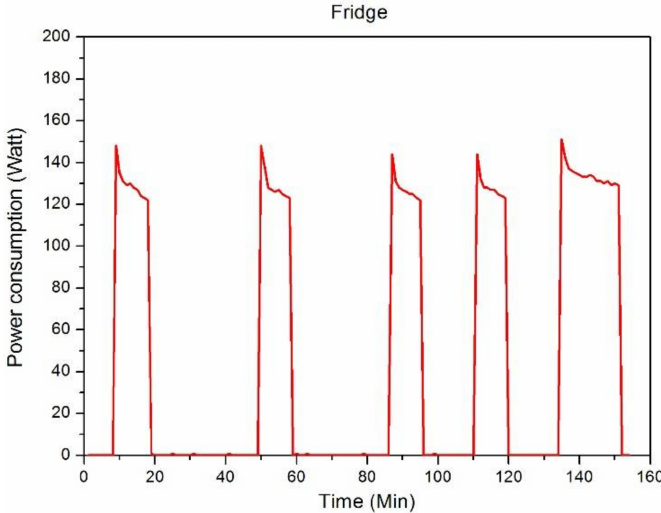
Figure 1. Power consumption pattern trajectory for fridge in AMPds